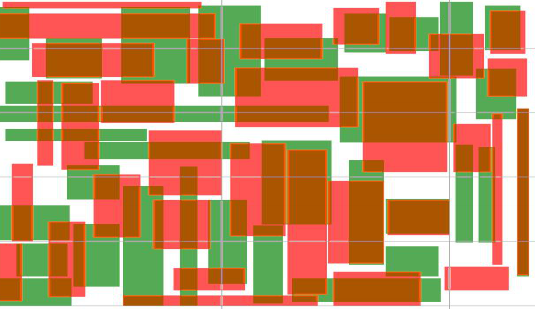
Figure 3. An example of scheduling, where red and green rectangles represent different